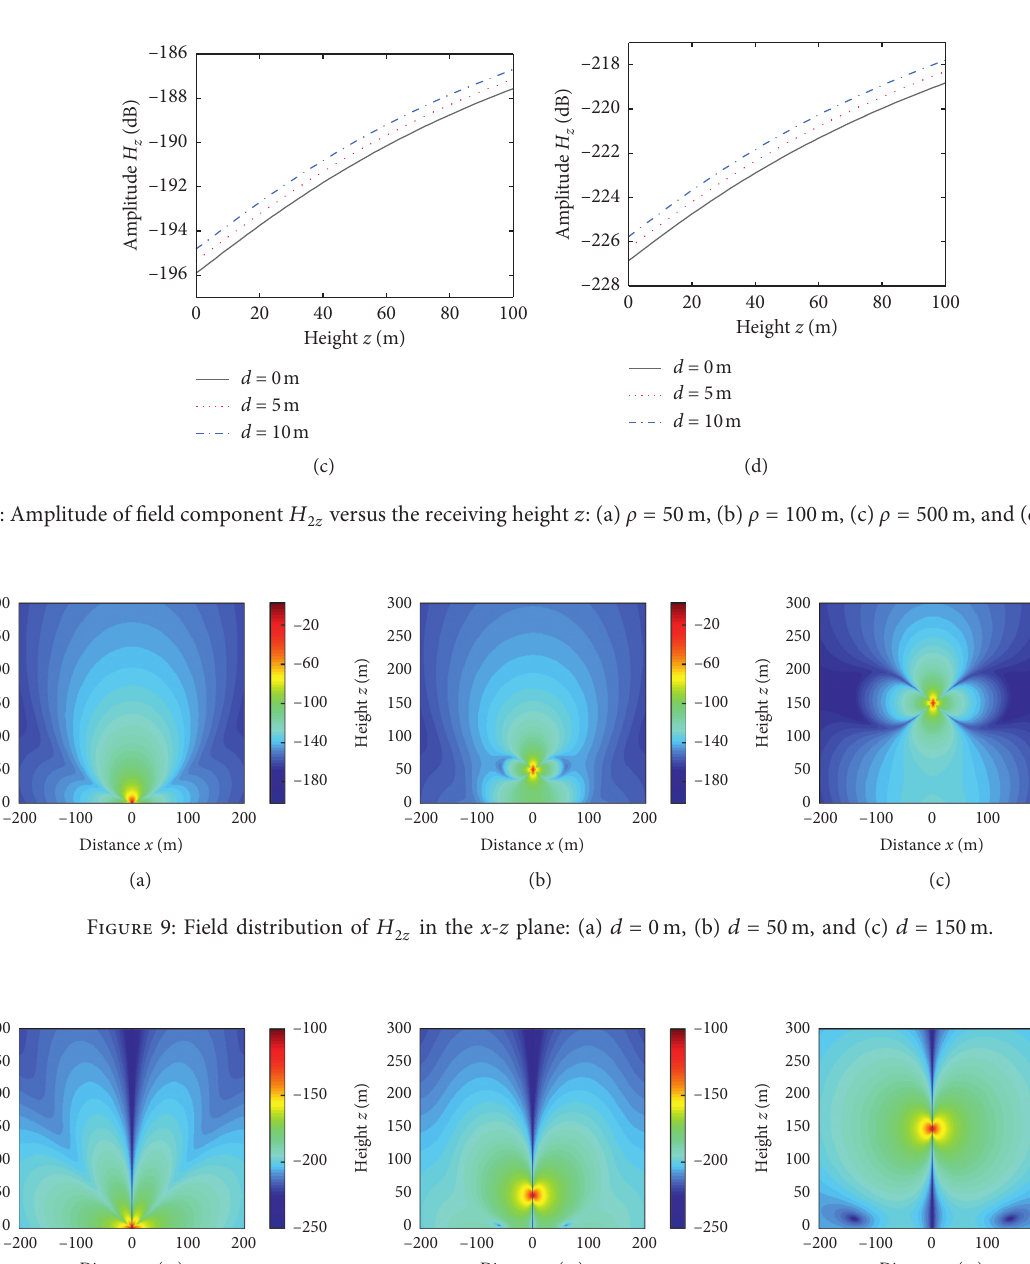
in the x - z plane: (a) d � 0 m, (b) d � 50m, and (c) d � 2 φ